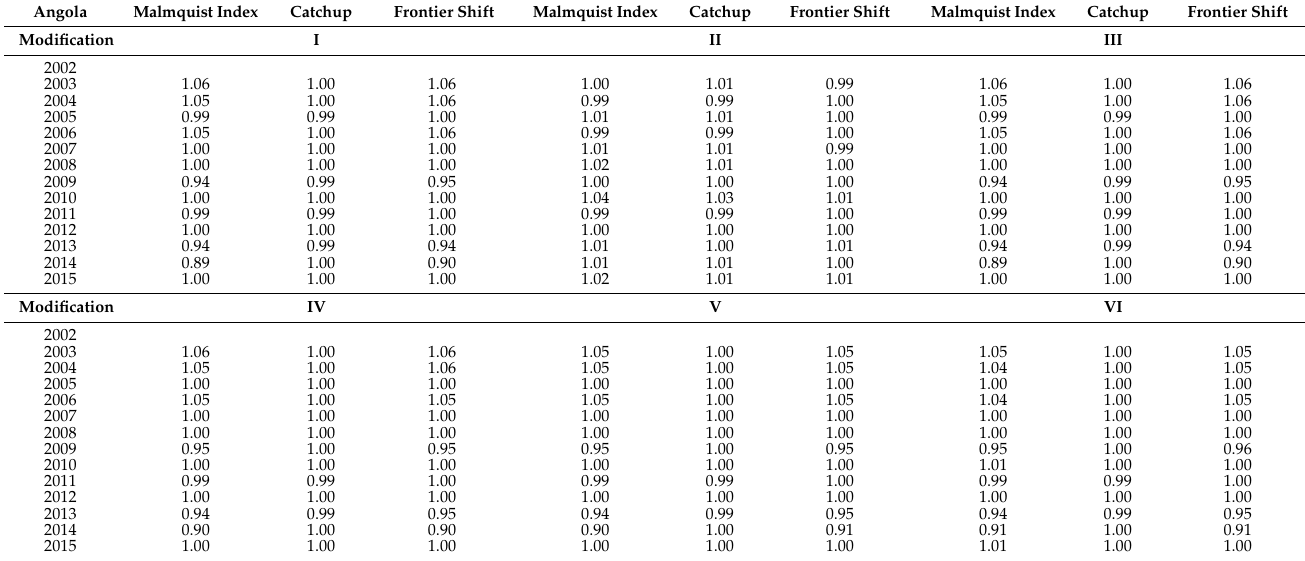
Table 6. Results of DEA Malmquist modifications for